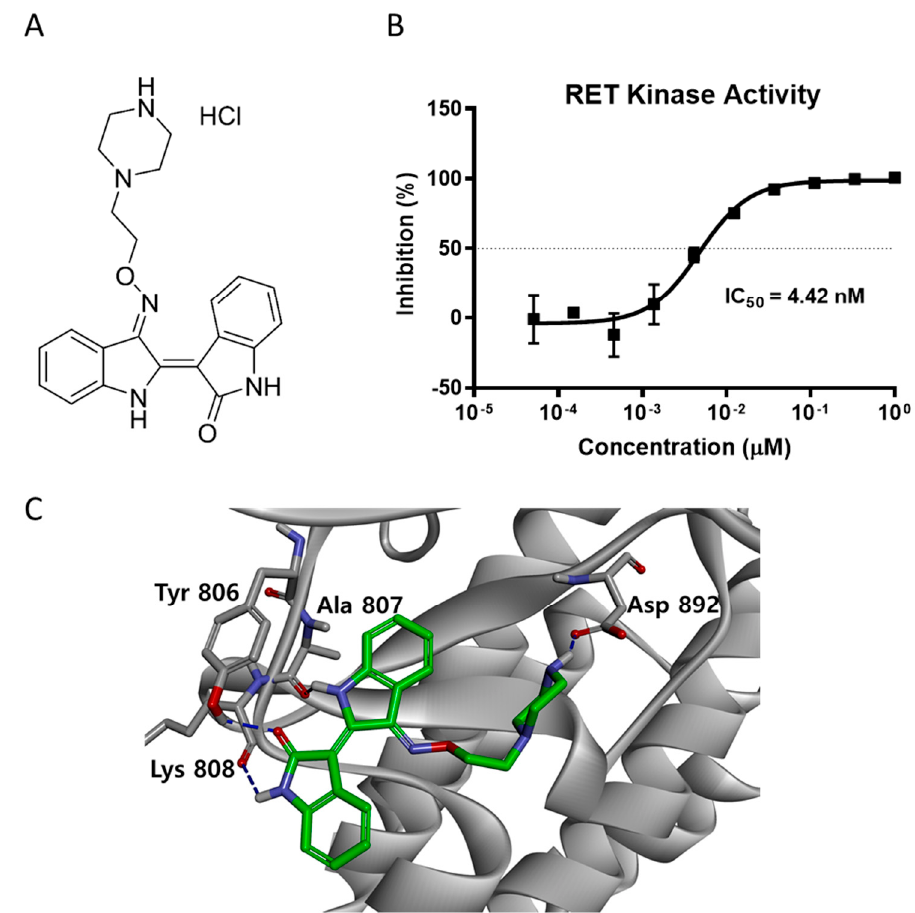
Figure 1. RET kinase activity inhibition by LDD-2633 ( A ) Chemical structure of LDD-2633 ( B ) Effect of LDD-2633 on in vitro RET kinase activity. The TR-FRET method was employed to measure in vitro kinase activity using recombinant RET protein. Data are presented as the mean ± SEM of three independent experiments. ( C ) Binding mode of LDD-2633 in the ATP binding site of RET kinase. Molecular docking was performed using the X-ray crystal structure of the RET protein (PDB code: 2X2K). Residues incorporated by hydrogen bonding in the ATP binding site are denoted in gray color. The network of hydrogen bonds is represented with the blue dashed line.